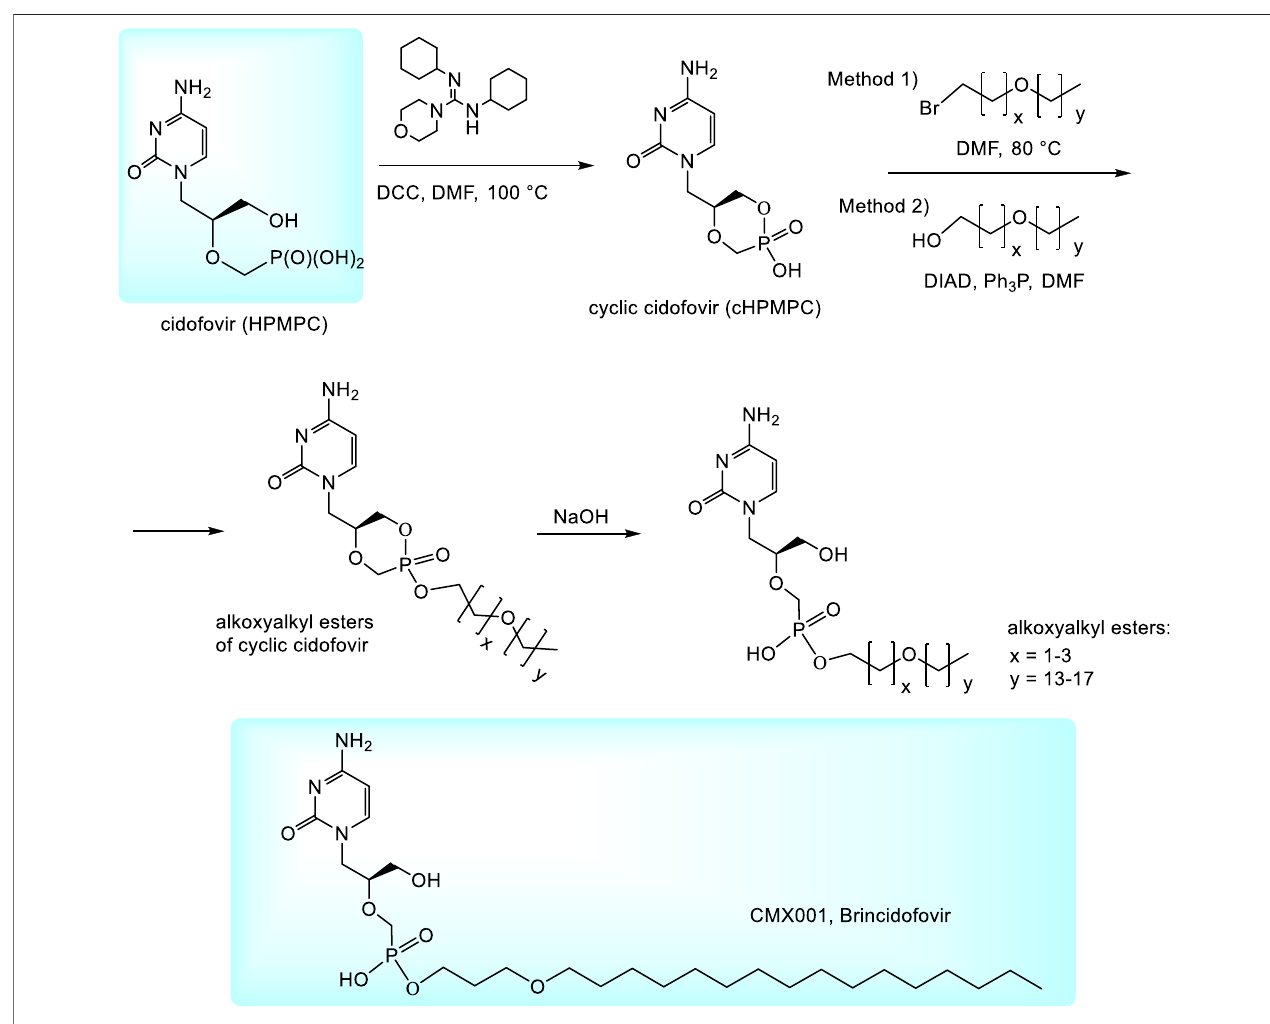
FIGURE 2 | Synthesis of alkoxyalkyl ester prodrugs of cidofovir.